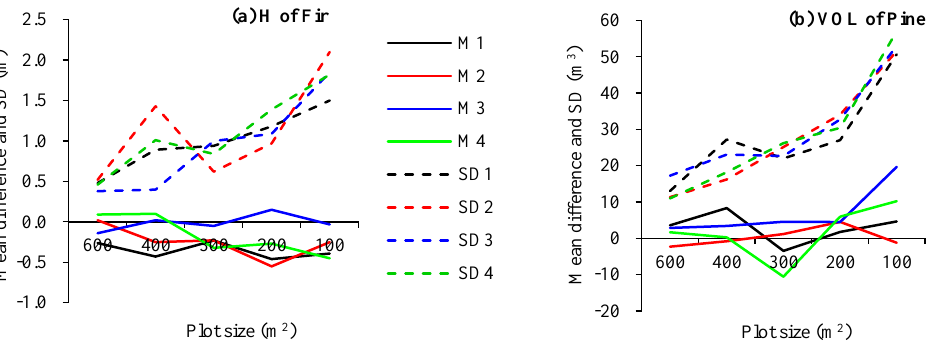
Figure 4. Means and standard deviations of the differences in measured forest attributes between plots of different sizes and 900 m 2 plots. M1 – M4 and SD1 – SD4 are the mean differences and their standard differences for protocols 1 – 4, respectively. ( a ) mean height of the Chinese fir forests, and ( b ) stand volume of the pine forests.